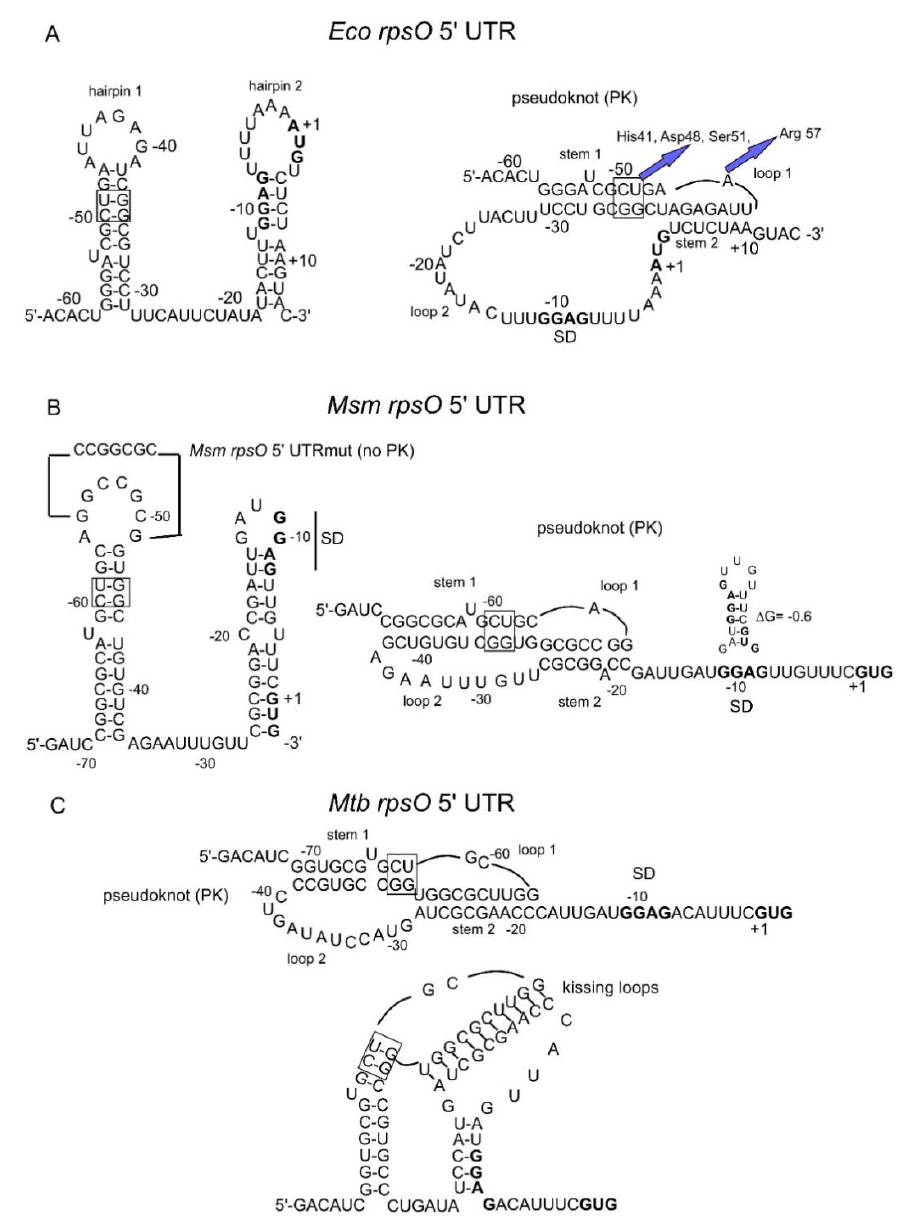
Figure 4. Comparison of the well-studied operator structure for E. coli rpsO ( A ), with predicted rpsO 5′ UTR structures for Msm ( B ) and Mtb ( C ). The style of presentation is adopted from [46] as it allows for the revelation of more obvious similarities and differences in the RNA folds. Initiator codons and SD sequences are in bold, and a conserved U-G/C-G motif is framed. ( A ) Two topologically distinct conformations of the E. coli rpsO regulatory site — two stem-loops (hairpins 1 and 2) and a pseudoknot. The uS15 recognizes two sites in the pseudoknot (shown by blue arrows); respective amino acid residues involved in recognition according to [13] are indicated. ( B ) Two predicted conformations of the Msm rpsO 5′ UTR (two hairpins and a pseudoknot) have a strong resemblance to the E. coli rpsO 5′ UTR structures. Changes able to prevent the pseudoknot formation are shown above hairpin 1. A small hairpin shown above the ribosome binding site was predicted to exist in the most stable variant of the Msm rpsO pseudoknot structure (Figure 1C). ( C ) Predicted secondary structures for the Mtb rpsO 5′ UTR (see Figure 1C): a pseudoknot bears resemblance to the Msm rpsO pseudoknot but may become more compacted by forming a structure of “kissing loops”.